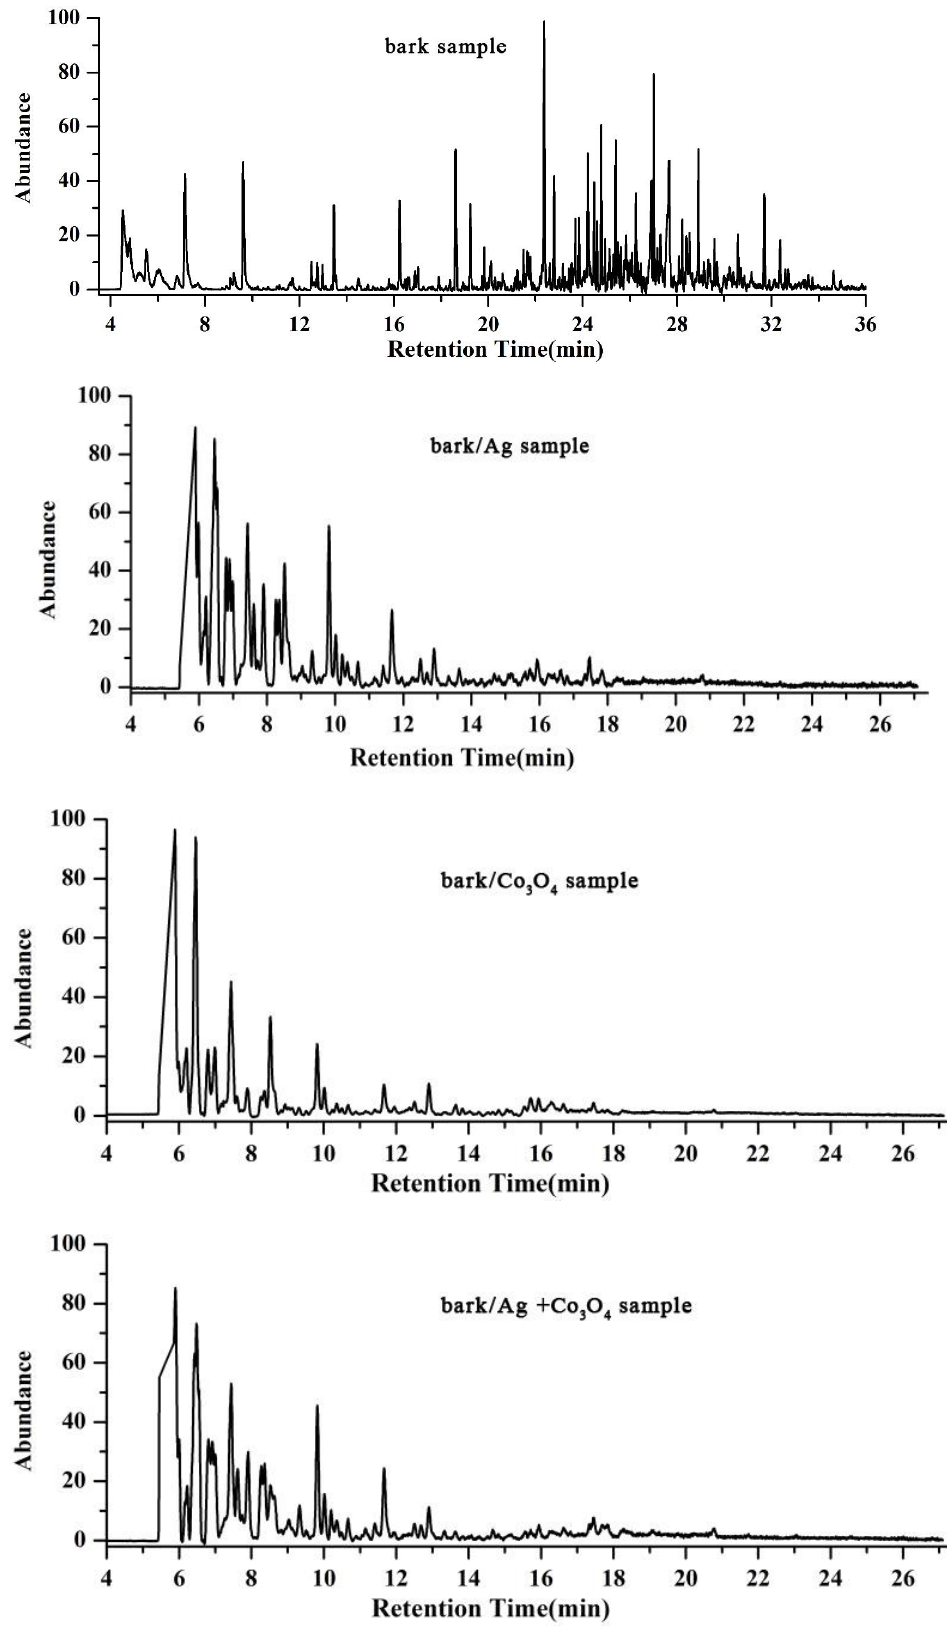
Figure 4. Total ion chromatograms of RPBs by PY-GC-MS.